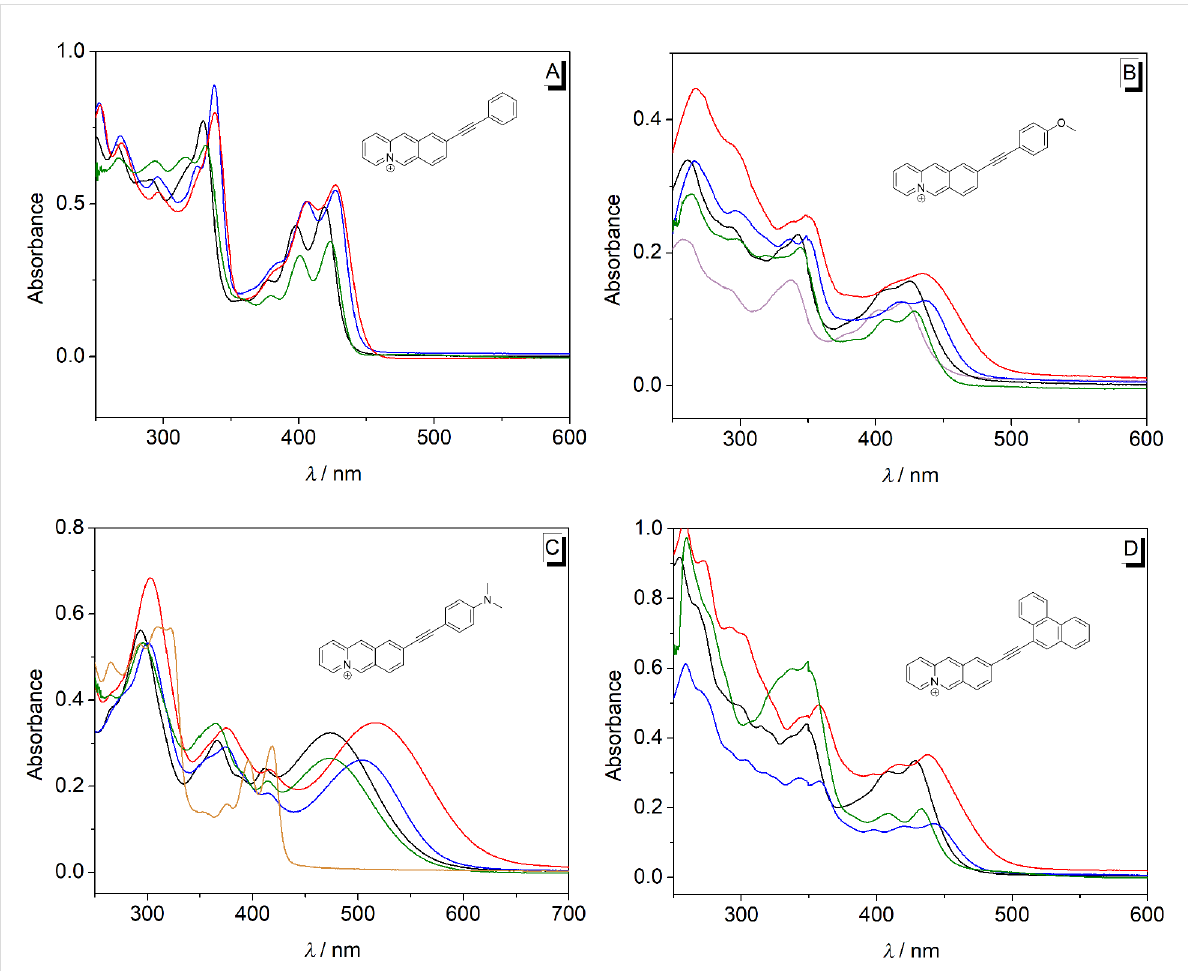
Figure 3: Absorption spectra of derivatives 2a (A), 2b (B), 2c (C) and, 2d (D); c = 20 μ M; solvents: H 2 O (magenta), MeOH (black), CHCl 3 (blue), CH 2 Cl 2 (red), DMSO (green) and 1 N HCl